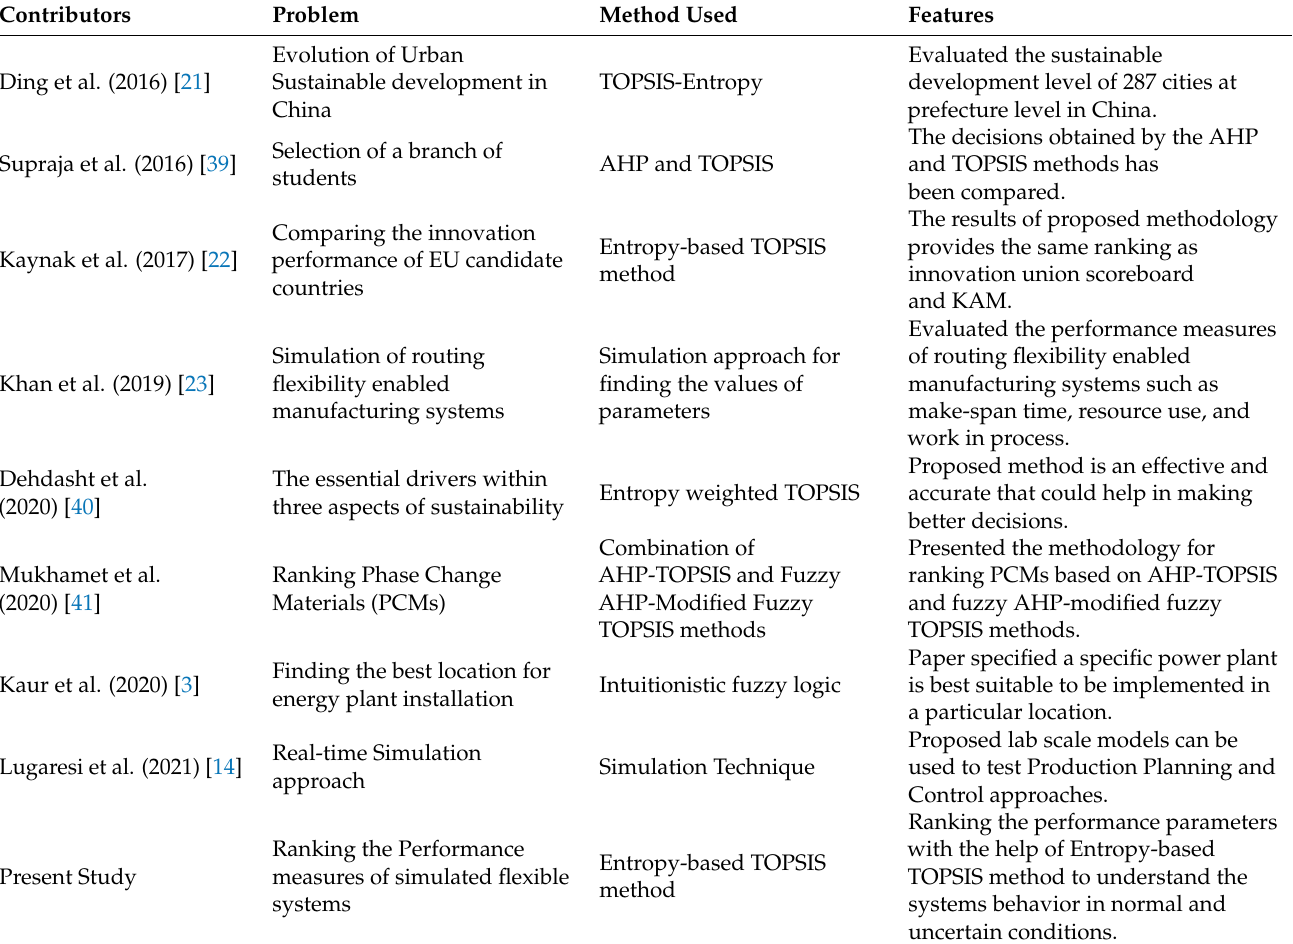
Table 1. Comparison of features of the present review with the latest